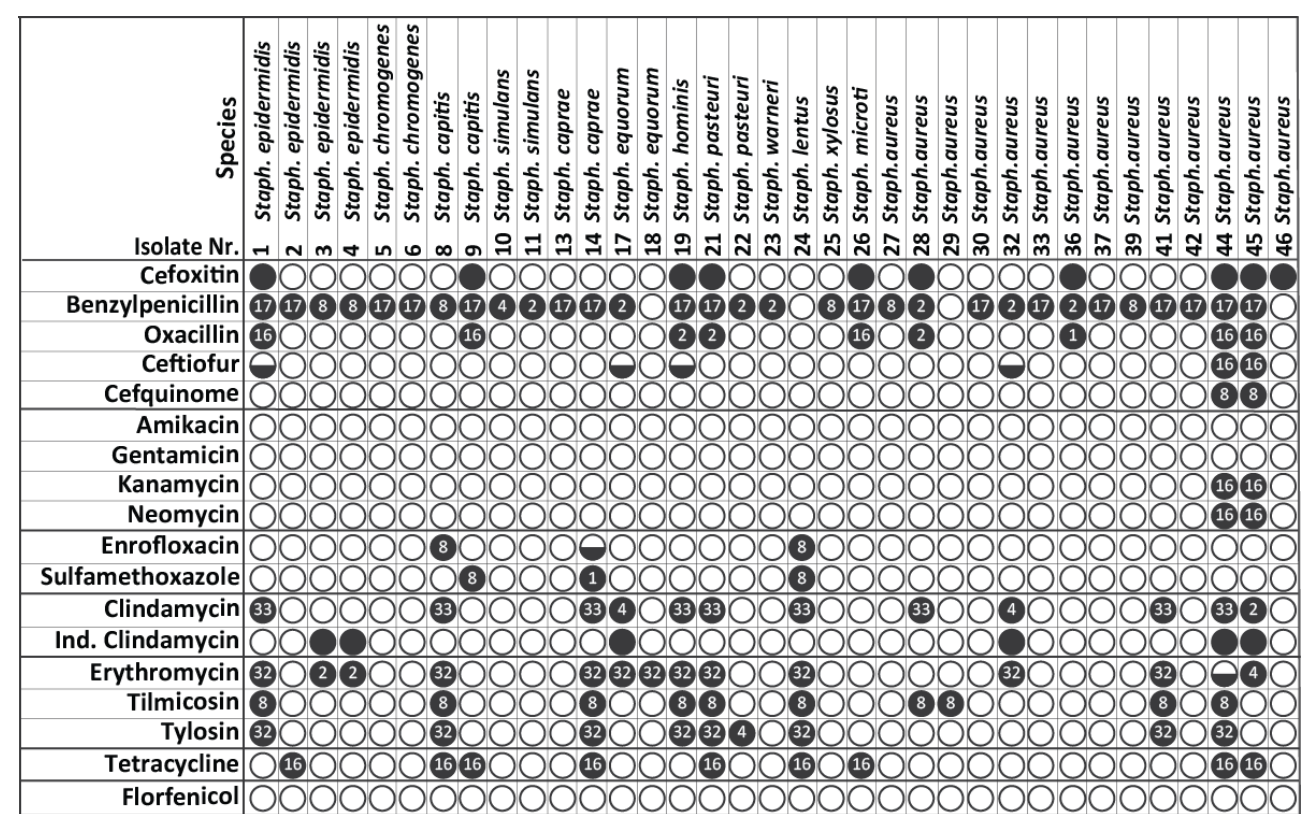
Table 2. Presence of nuc , SCCmec / orfX , mecA and mecC in the tested MRSA and MR-CoNS strains.